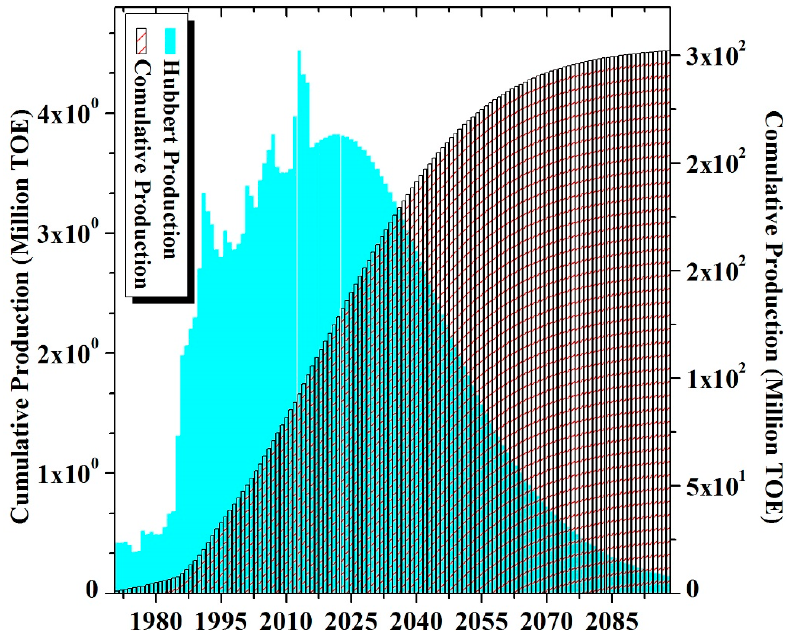
Figure 17. Hubbert and cumulative production peak for oil (Million toe).